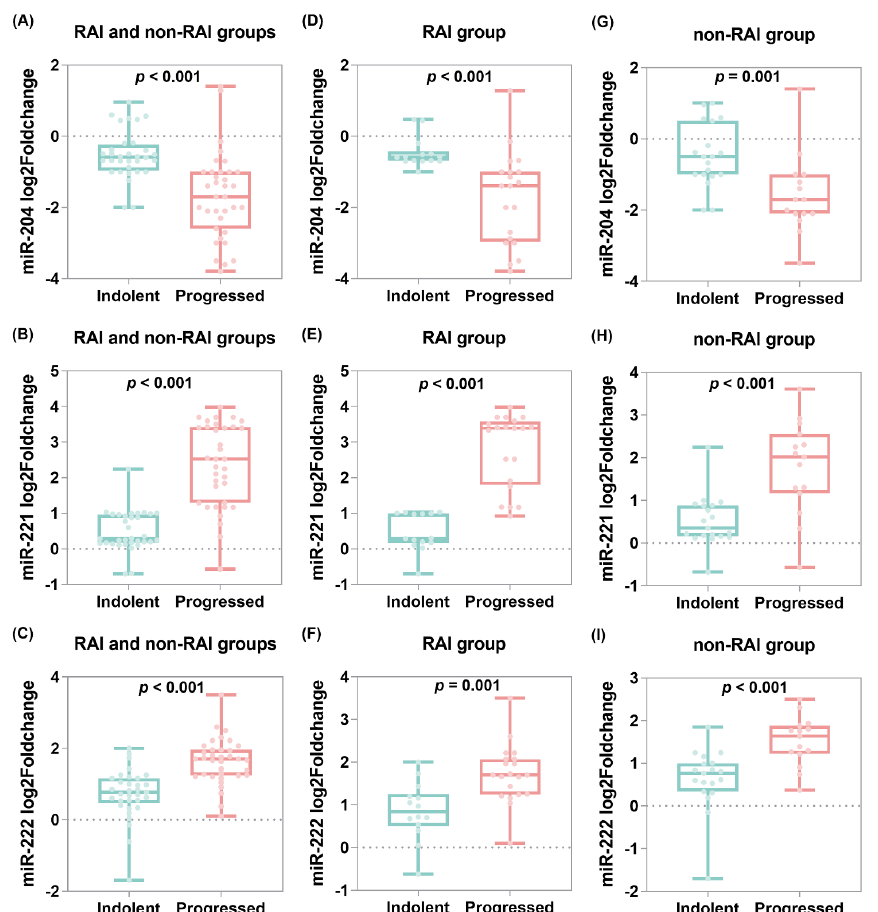
Figure 4. Tissue microRNA expression profile and tumor progression. Plots represent overall analysis for the 68 patients and subgroup analysis for the 34 patients in the RAI group. Mann – Whitney U test was used to compare the expression levels between indolent and progressive samples. Log2 fold change was estimated using the ddCT method. ( A – C ) Overall analysis, ( D – F ) RAI group, and ( G – I ) non-RAI group. The three miRNAs showed good accuracy to predict tumor progression in overall and subgroup analysis. The AUC of miR-204 was 0.85 (95% CI = 0.75 – 0.93, p < 0.001) and 0.91 (95% CI = 0.75 – 0.98), miR-221 was 0.93 (95% CI = 0.82 – 0.97, p < 0.001) and 0.97 (95% CI = 0.87 – 1.0, p < 0.001), and miR-222 was 0.85 (95% CI = 0.74 – 0.92) and 0.83 (95% CI = Table 4. Predictive accuracy of microRNAs in forecasting probabilities of tumor 0.66 – 0.94, p < 0.001). In contrast, the ATA risk score did not show significant discrimina- tive ability shown in the ROC curve (AUC = 0.613, 95% CI = 0.487 – 0.729, p = 0.06) with high error probability (cost = 0.412) (Table 4). Comparison between the AUC of the three miRNAs showed an insignificant difference between them, highlighting having similar